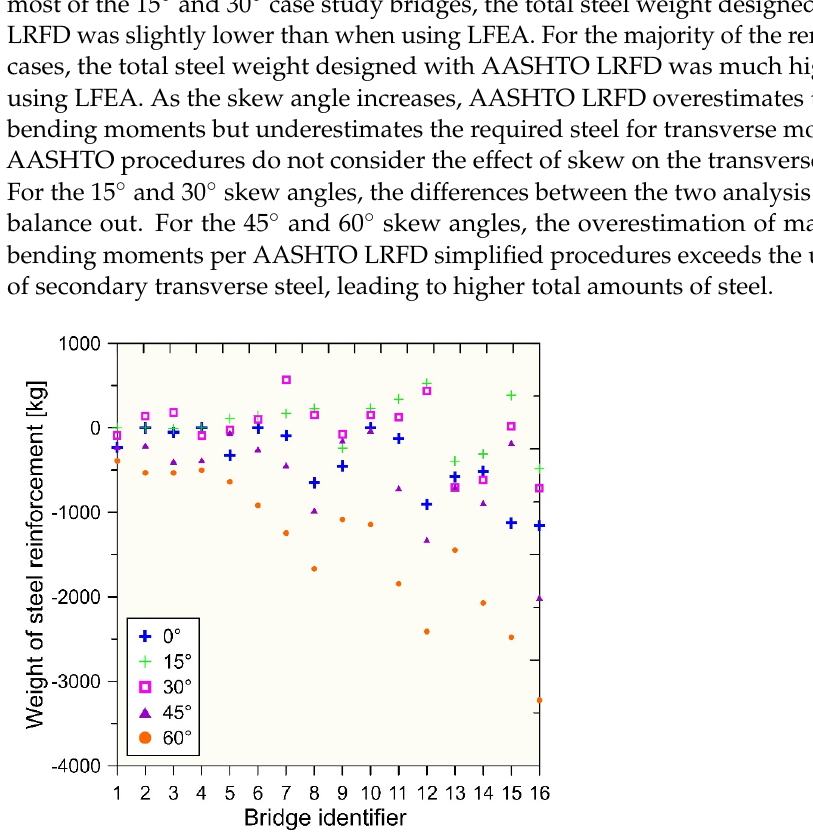
Figure 13. Difference (in kg) between total weight of reinforcement determined with LFEA and AASHTO LRFD. The difference is determined as the amount of steel designed using LFEA minus the amount required by AASHTO LRFD. Bridge identifiers are explained in Table 7.